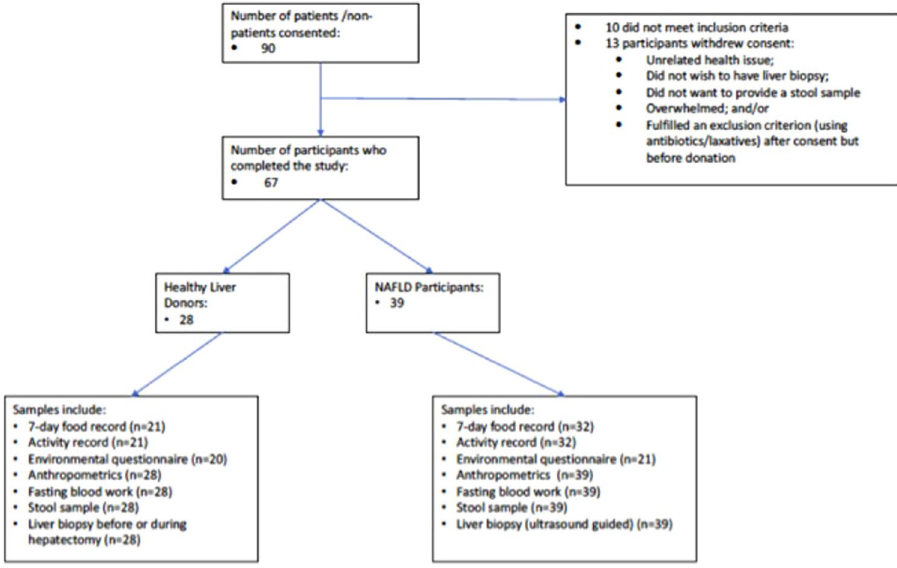
Figure 1. Subject recruitment and sample collection flow